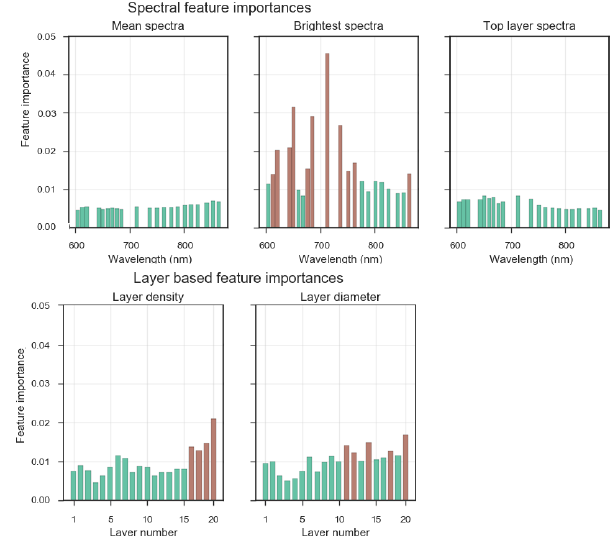
Figure 6. Individual importance for each feature in all feature sets. The 20 most influential features are highlighted